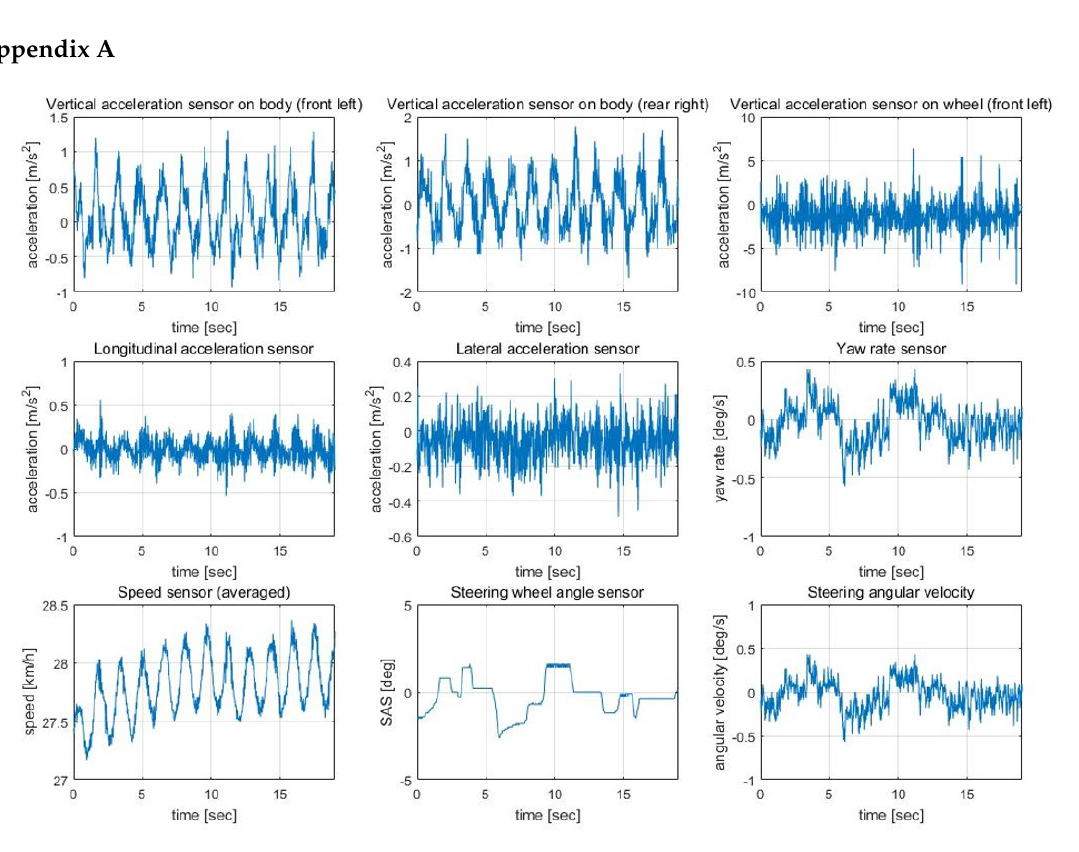
Figure A1. Sensor data on sinusoidal road, 30